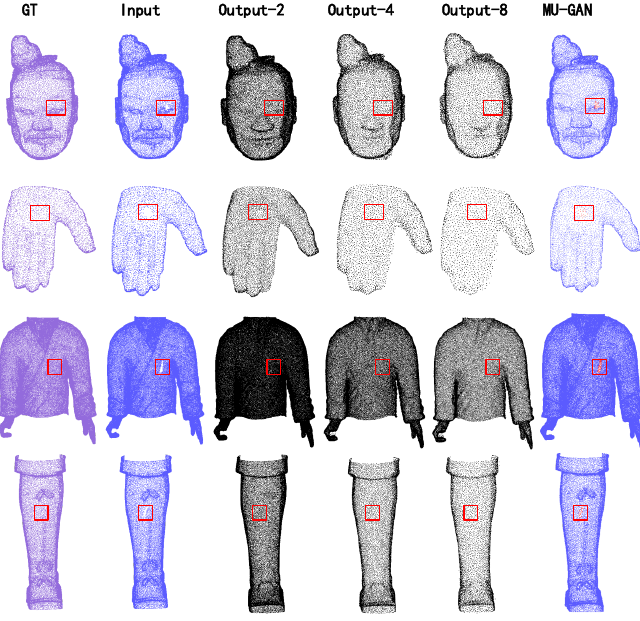
Figure 7. Experimental results of different CHarts models with small holes. Output-2, Output-4, and Output-8 denote the point cloud generated from 𝑃 1 , 𝑃 2 , and 𝑃 3 separately. The text continues here.